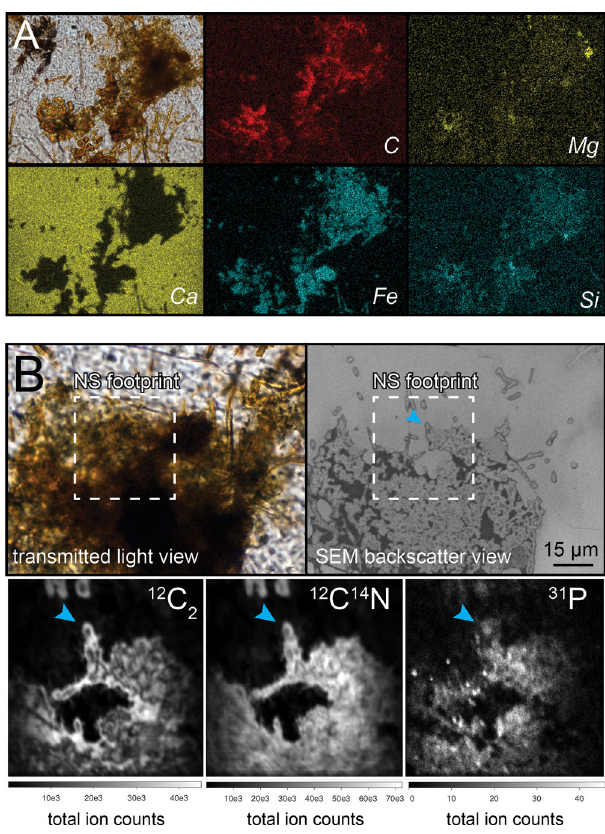
Fig. 3 Compositional maps of iron oxide & fi lament